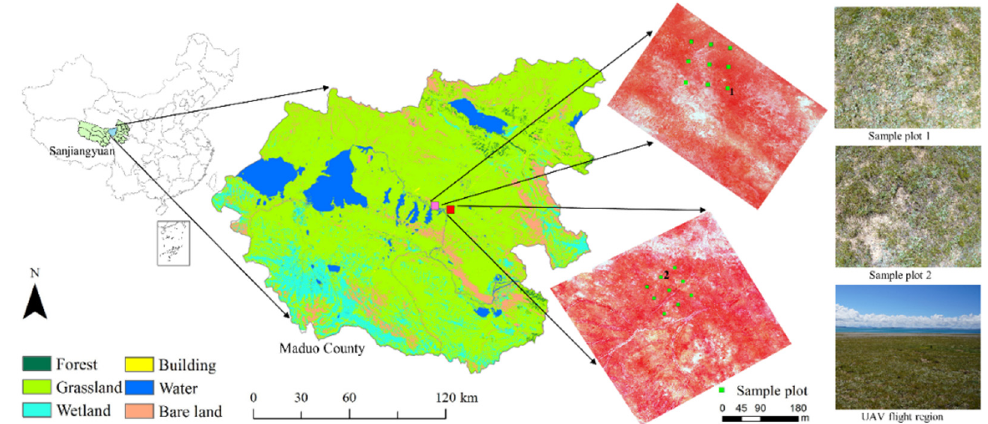
Figure 1. The location of Sanjiangyuan National Nature Reserve ( left ), Maduo county ( middle ) with land cover data with 10 m spatial resolution from ChinaCover2020 [67], and two UAV imaging spectroscopy images (NIR: 860 nm, red: 660 nm, green: 560 nm) with 18 field-measured sample plots and photographs (right).